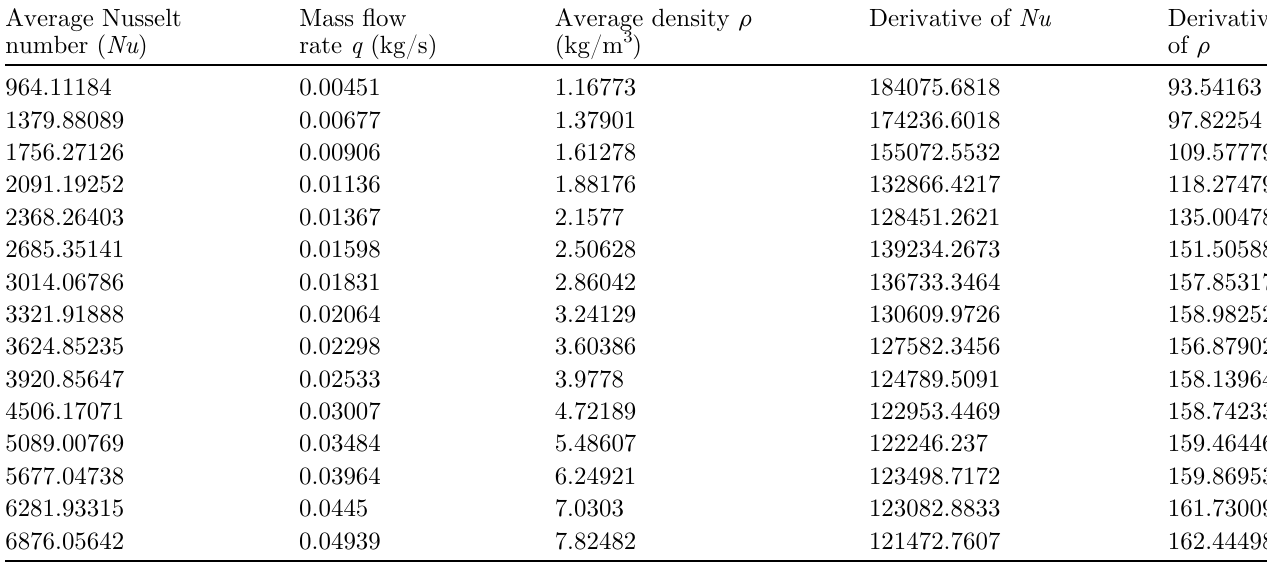
Table A1. Raw data used in Figure 18a.